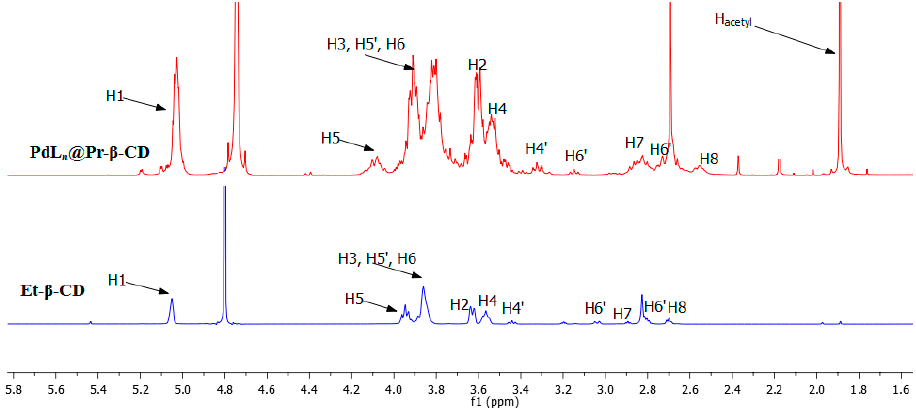
Figure 1. 1 H NMR spectra of Et ‐β‐ CD and PdLn@Et ‐β‐ CD.